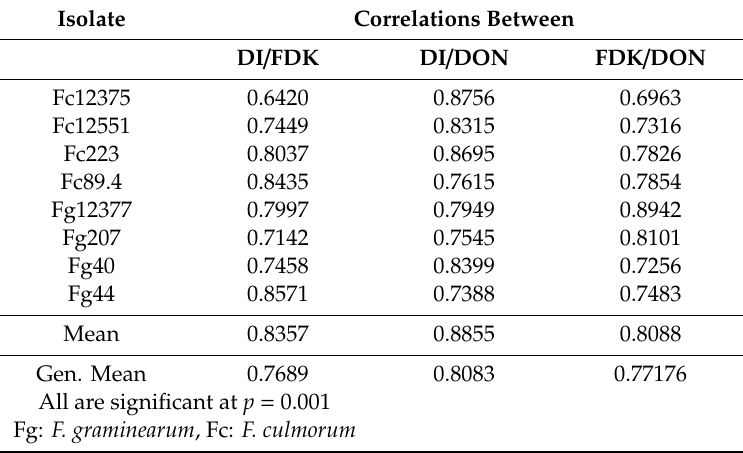
Table 1. Isolate specific correlations between traits of the second resistance tests with eight isolates of Fg : F. graminearum , Fc : F. culmorum F. graminearum and F. culmorum , 1994–1996. No. of genotypes = 25 [34].